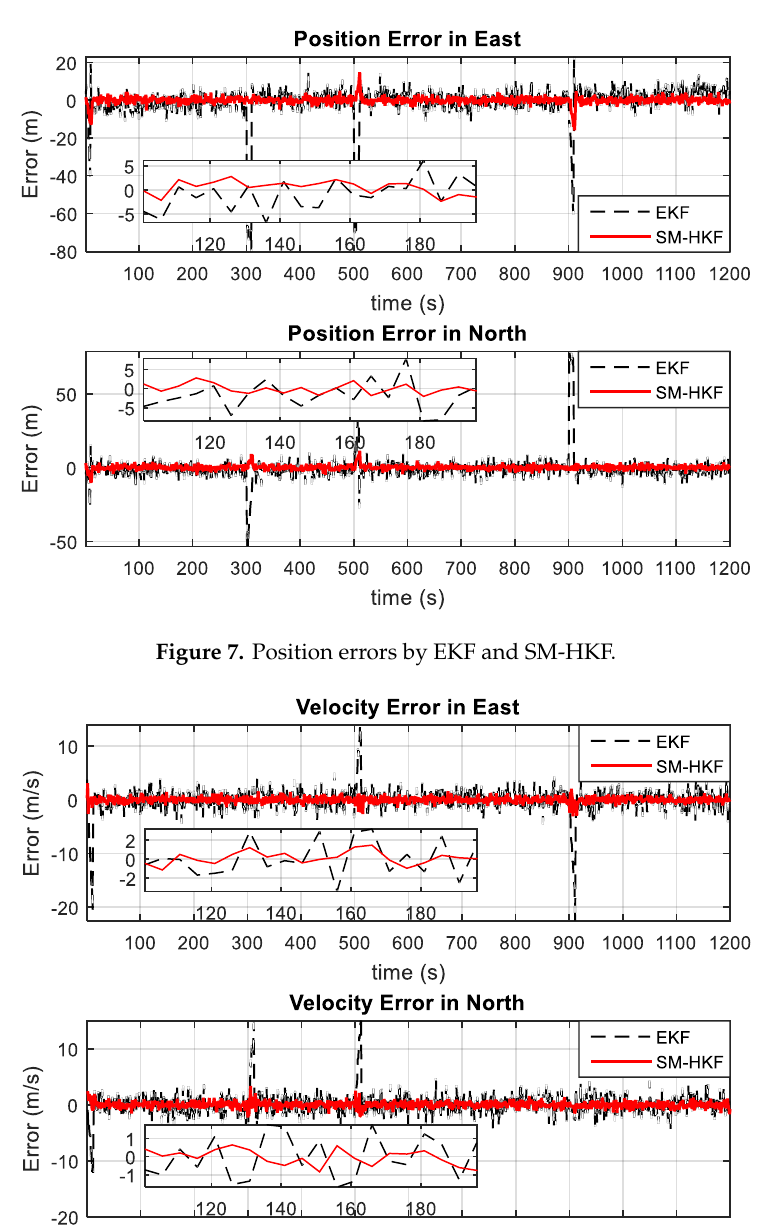
Figure 6. The velocities in North estimated by EKF and SM-HKF from 490 s to 520 s.